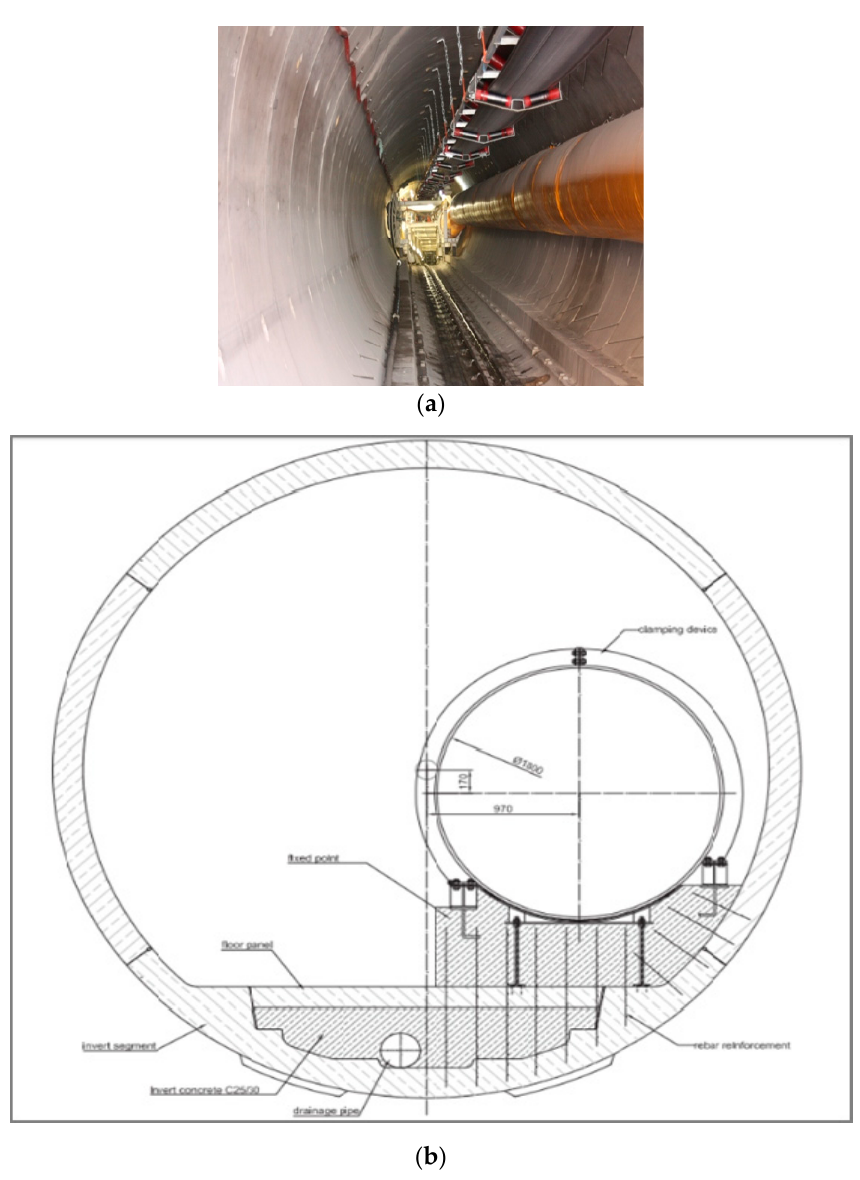
Figure 11. Panoramic view of the project.